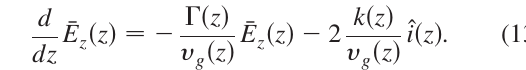
Figure 1 is a space/time plot of the linac for 0 (cid:7) t (cid:7) t fill and 0 (cid:7) z (cid:7) l . The leading particles progress through the structure on the diagonal dashed line, and the structure is filled with both beam and rf power at time t . The shaded fill region is linac under beam loading, while the unshaded region evolves without beam. The static field (cid:2) E is estab- z lished on the dashed boundary between them (and later) ð z ¼ 0 ; t Þ during 0 (cid:7) t (cid:7) t through the rf drive ^ E to be z inj determined in this